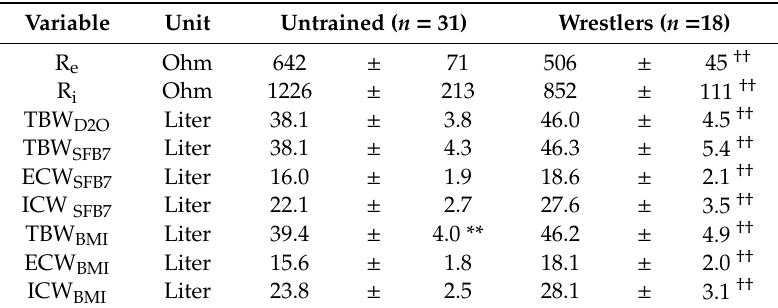
Table 2. Body resistance and body water content.